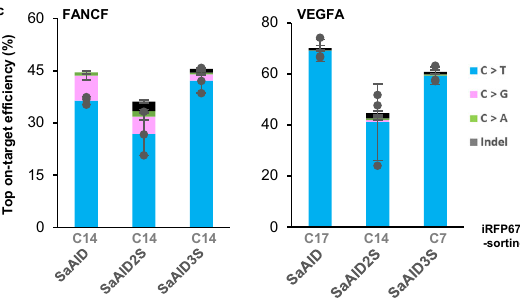
performed well except for site 8. R33A+ K34A showed target- dependence that obtain >20% of editing only in sites 3, 4, and 7. AID- 2S showed a narrower editing region, while AID-3S showed a shift of the editing window to the proximal side of the PAM sequence com- pared to the original